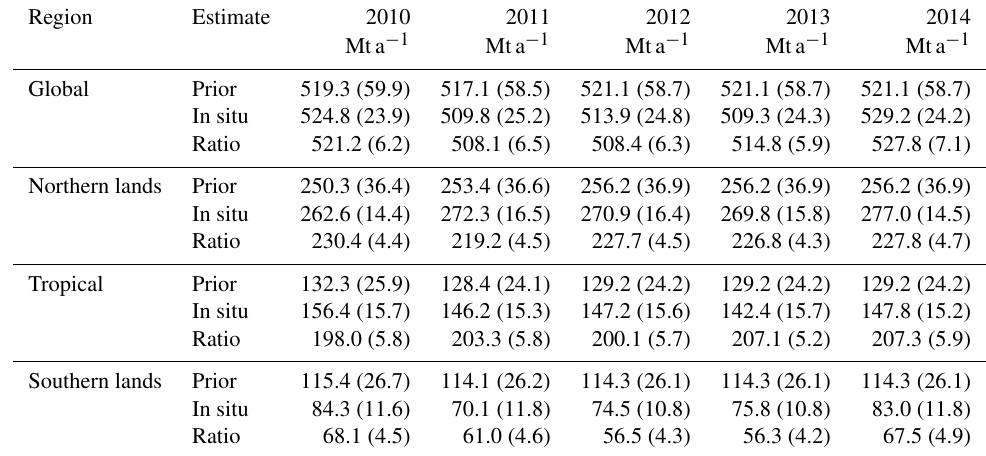
Table 2. The same as Table 1 but for CH 4 fluxes. Region